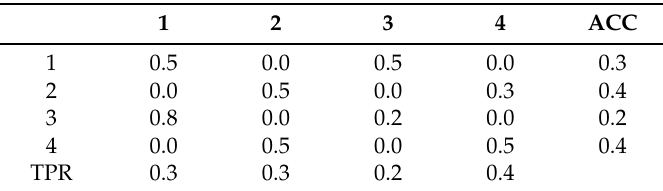
Table 6. Confusion matrix for different session numbers (S1–S4). Column headers represent predicted values and row headers represent actual values.